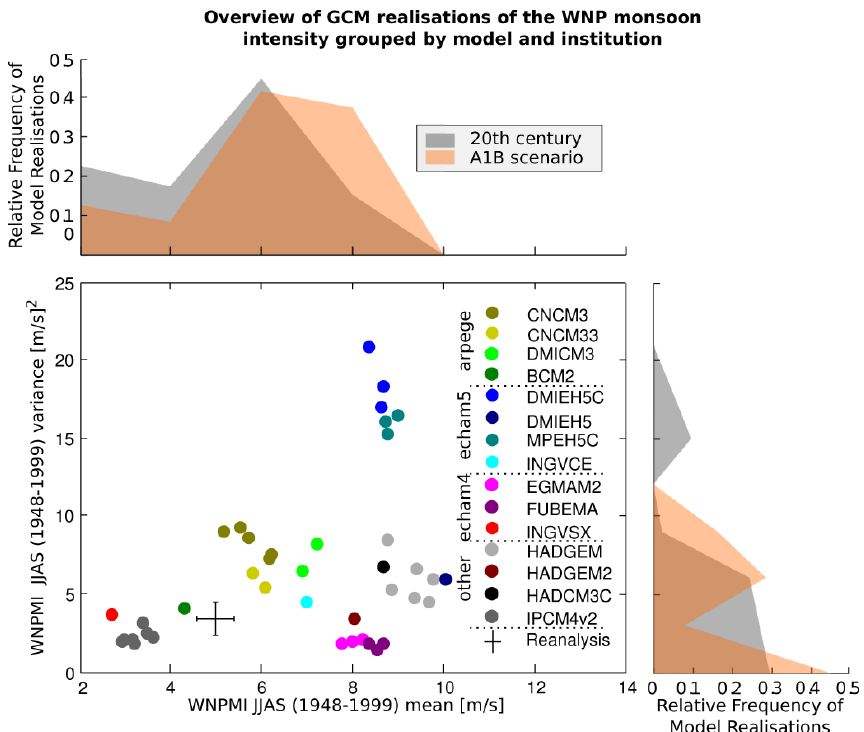
Figure 2. Realisations of WNP monsoon index mean and variance from single runs of the GCM ensemble for the period of 1948 to 1999. The results from the CC scenario A1B are also shown. The WNP monsoon index mean and variance as calculated from reanalysis data are given with 90% uncertainty